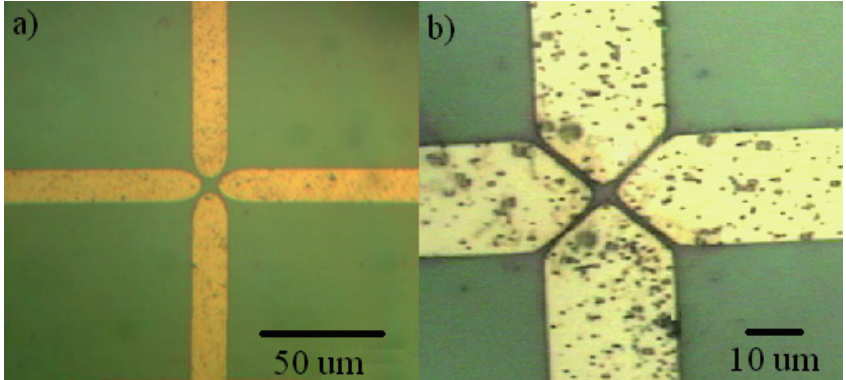
Figure 1. Quadrupolar microelectrodes with ( a ) 10 µm tip to tip spacing between opposite electrodes used for the collection of NAVDY particles and ( b ) 4 µm tip to tip spacing used for the collection of M13